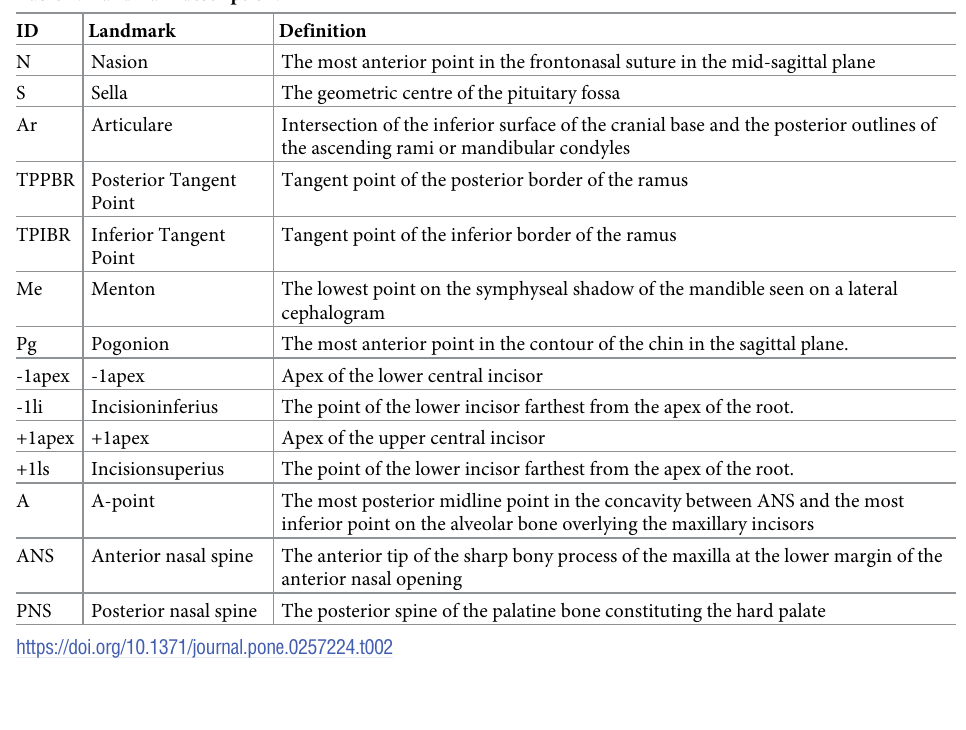
Table 2. Landmark